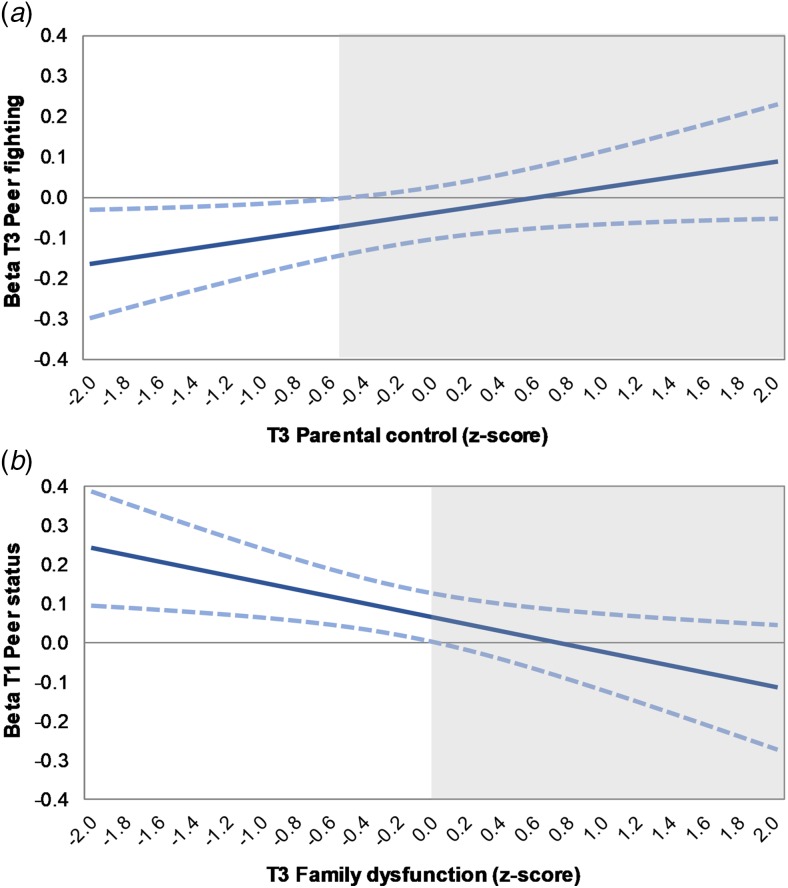
Johnson–Neyman plots showing (a) the conditional effect of T3 peer fighting for T3 parental control and (b) of T1 peer status for T3 family dysfunction on young adult multidimensional functioning. The non-shaded area indicates regions-of-significance.